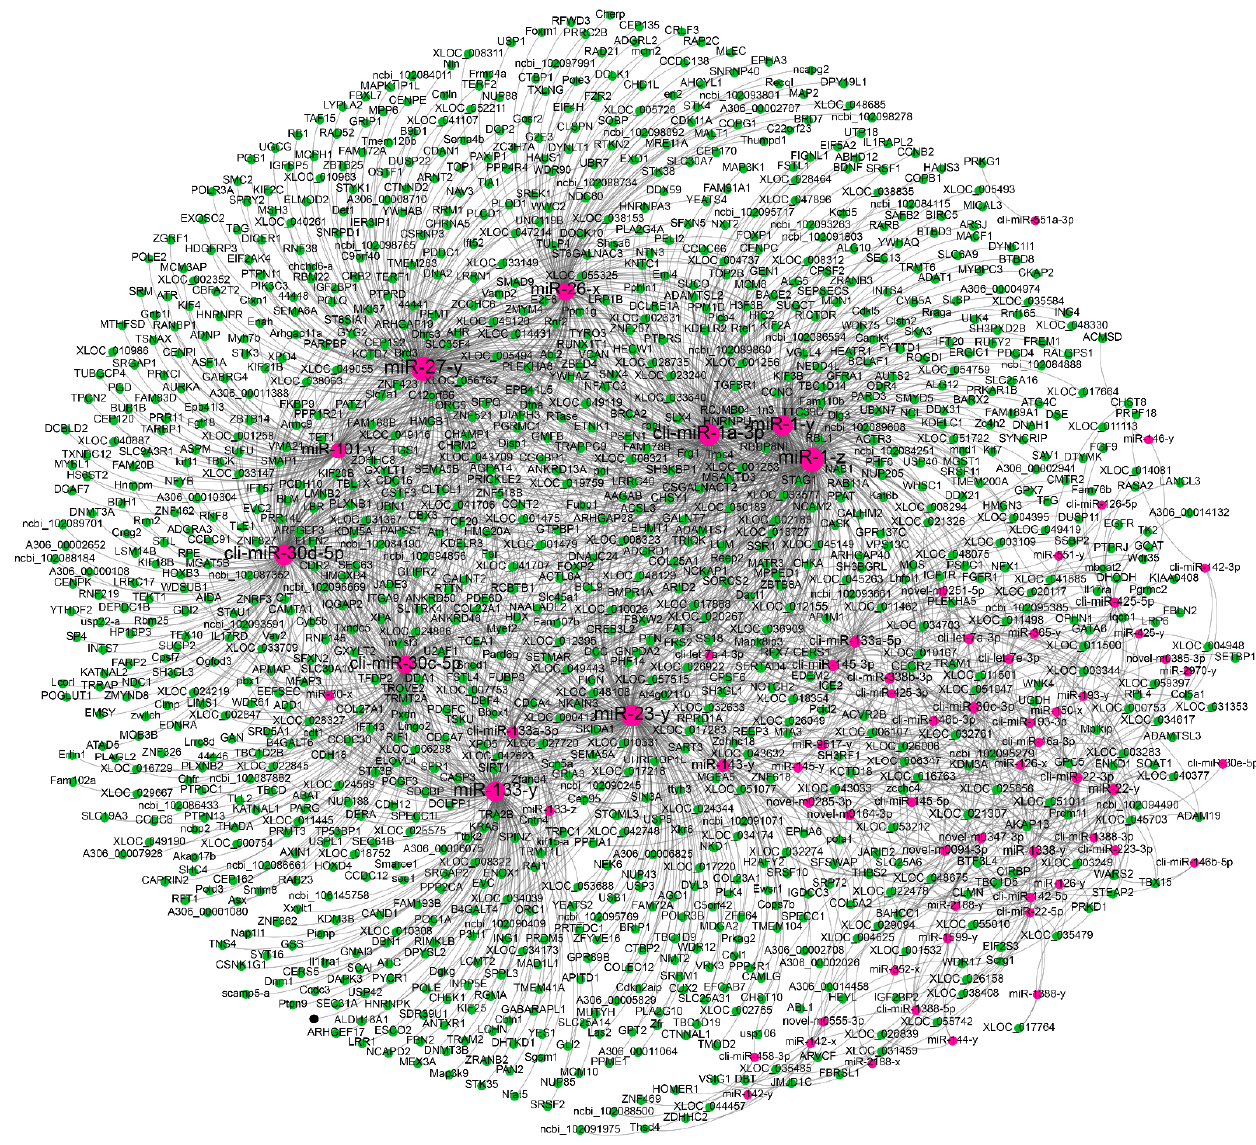
Figure 2. Visualization of the miRNA–mRNA regulatory networks.